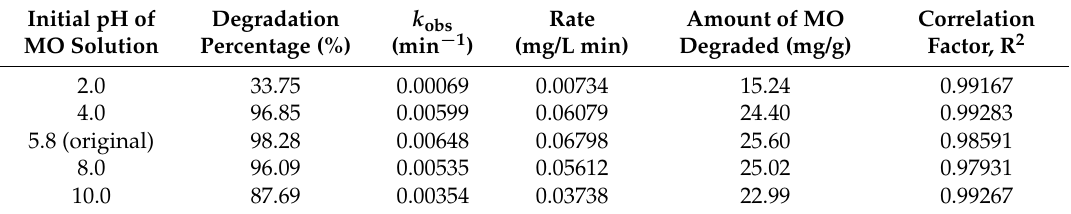
Table 2. Kinetic data and the amount of MO degraded at different initial pH by the PZ-17 film photocatalyst.